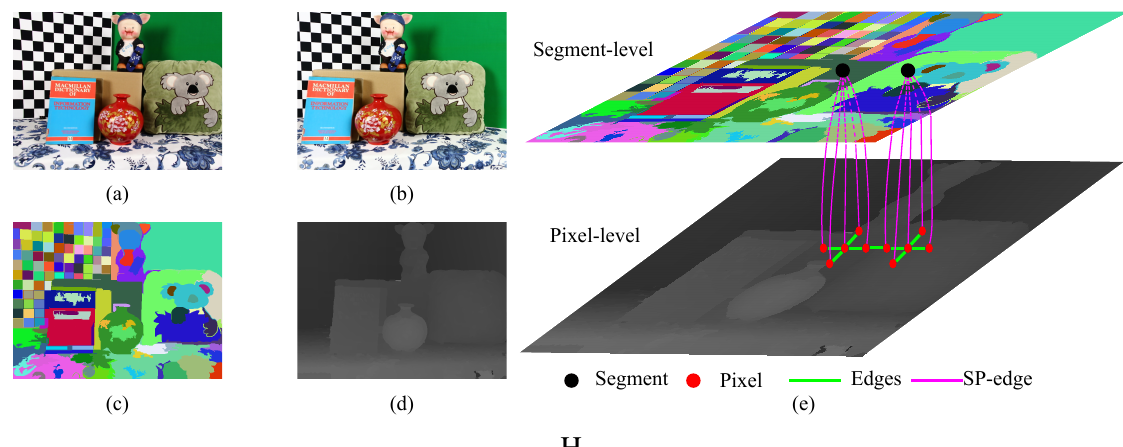
Figure 2. The illustration of the multiscale pseudo-two-layer (MPTL) model. The rectified left ( a ) and right ( b ) images from DLSRs, the segmentation; ( c ) as well as the depth map ( d ) from the depth sensor are taken as our inputs; ( e ) The conceptual structure of our